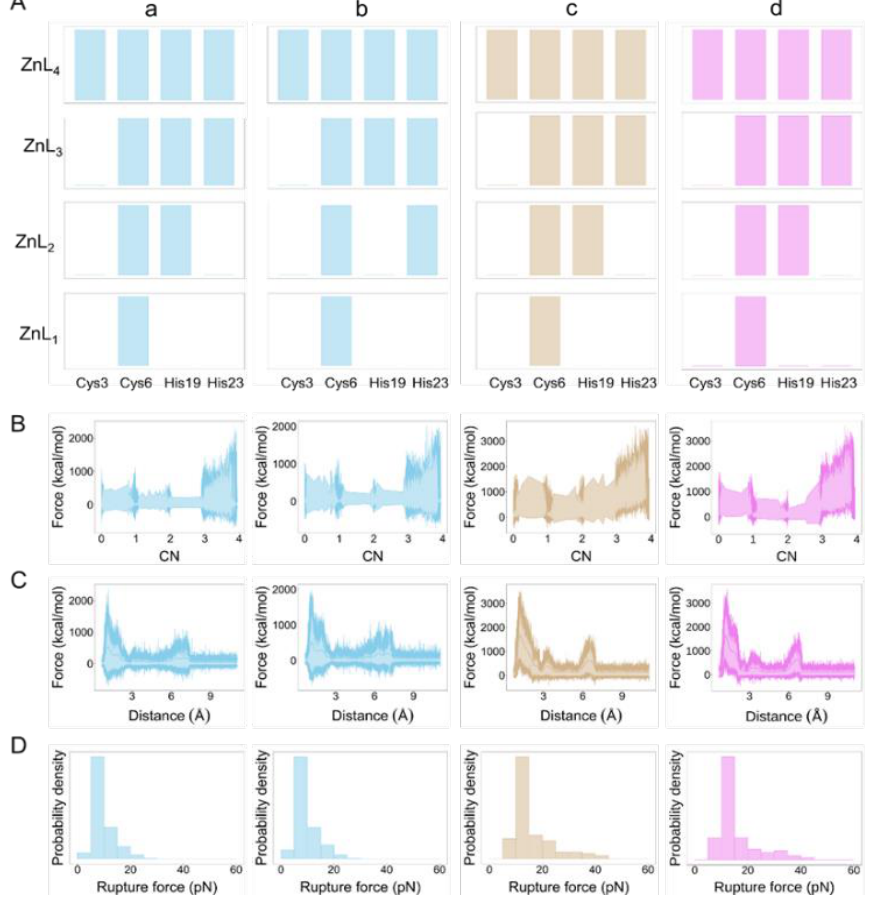
Figure 4. Steered MD simulations for the ZFs CP1-2015 and CP1-1991. ( A ) Stepwise ZnL dissociation for the CP1-1991 ( a ), CP-2015 pathway I ( b ), pathway II ( c ), and the CP1-1991 α ( d ). The bar represents the case when Zn(II) is bound to a particular ligand (L). ( B ) Force rupture as a function of the contact number (CN). CN was defined as the number of ligands bound to the Zn(II) ion. ( C ) Force–extension curves derived from the SMD simulations. ( D ) Rupture force histograms for each pathway.